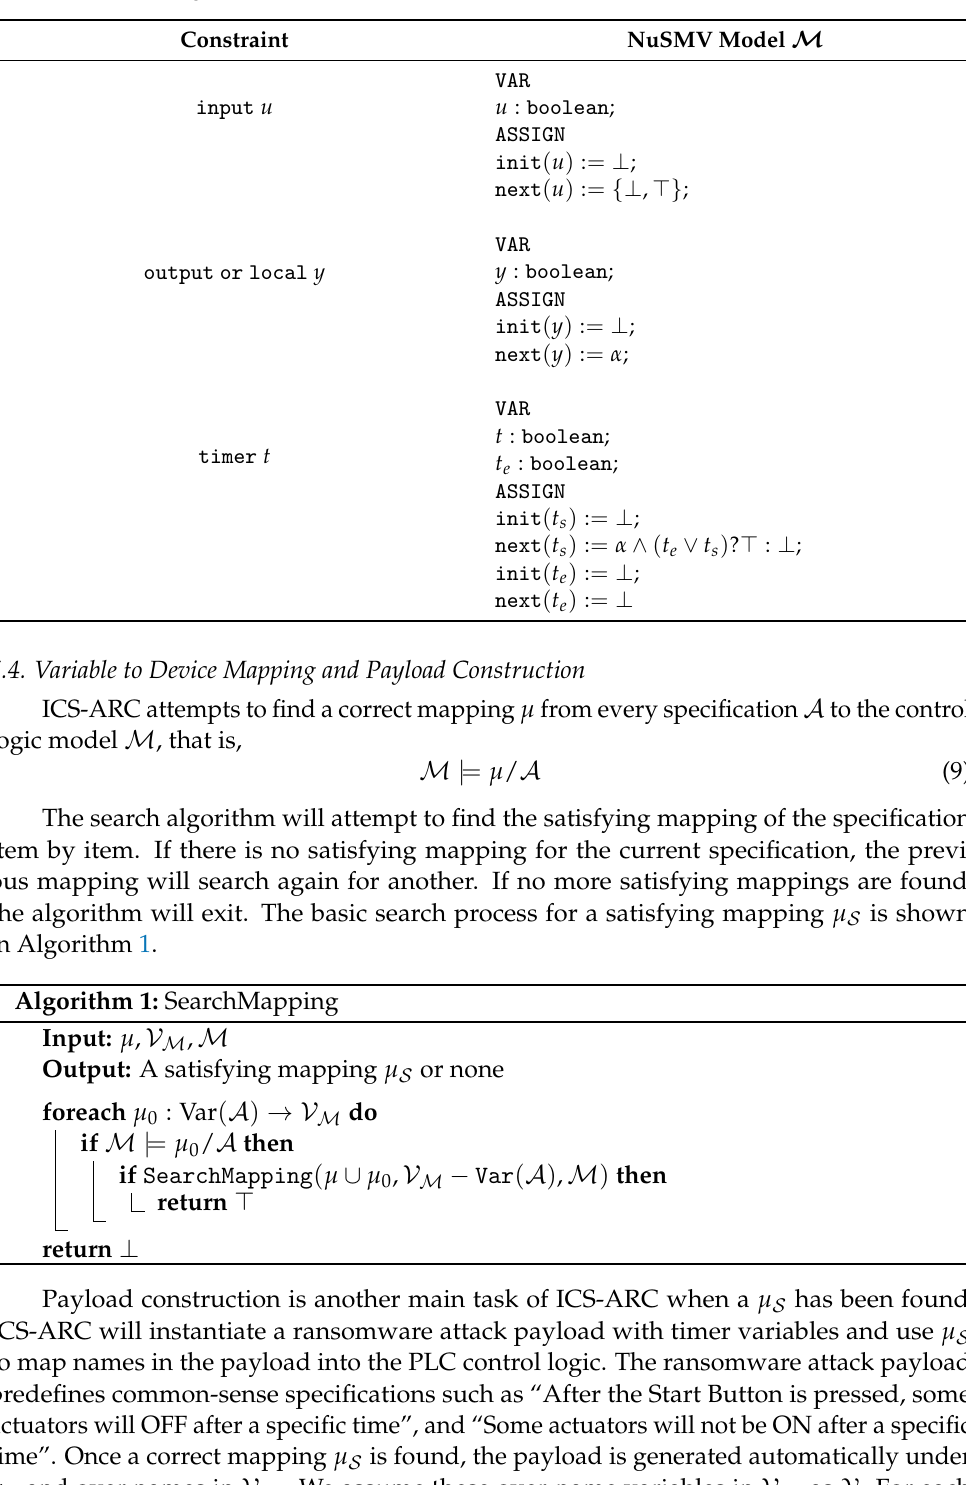
Table 2. Constructing M from constraints C